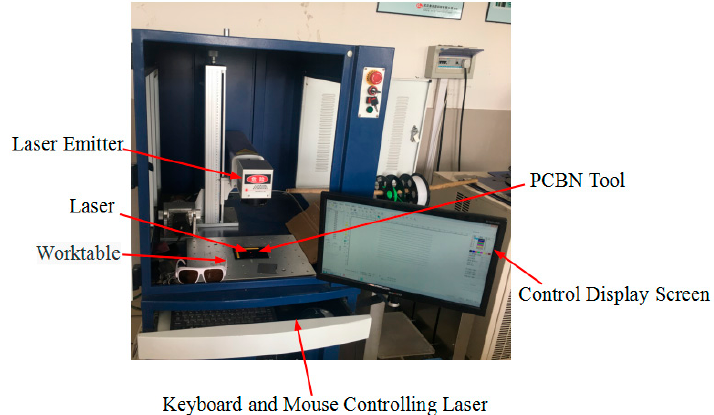
Figure 7. FLY-M10F fully enclosed rotating optical fiber laser marking machine.